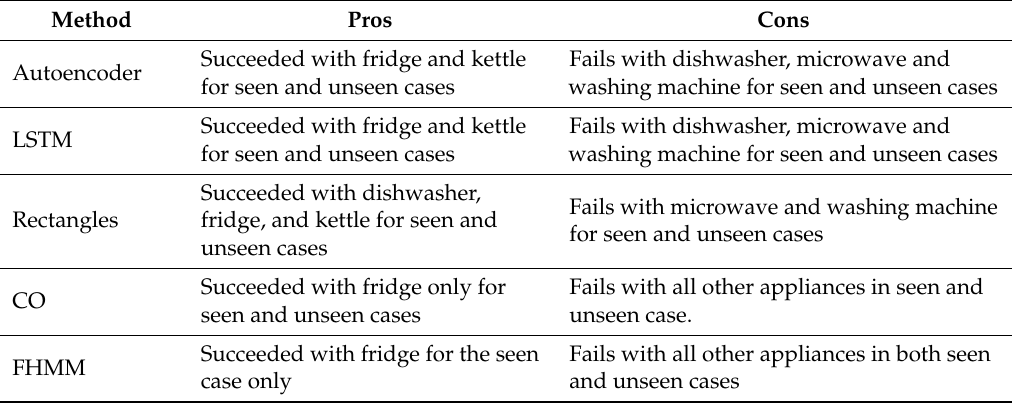
Figure 6. Shows the energy disaggregation algorithm output by using recurrent neural network (RNN) or LSTM technique. ( a ) Aggregated power consumption for the home; ( b ) dishwasher estimated and Ground truth power demand; ( c ) fridge estimated and Ground truth power demand; ( d ) kettle estimated and Ground truth power demand; ( e ) microwave estimated and Ground truth power demand; ( f ) washing machine estimated and Ground truth power demand. Table 1. Comparison between the disaggregation techniques.